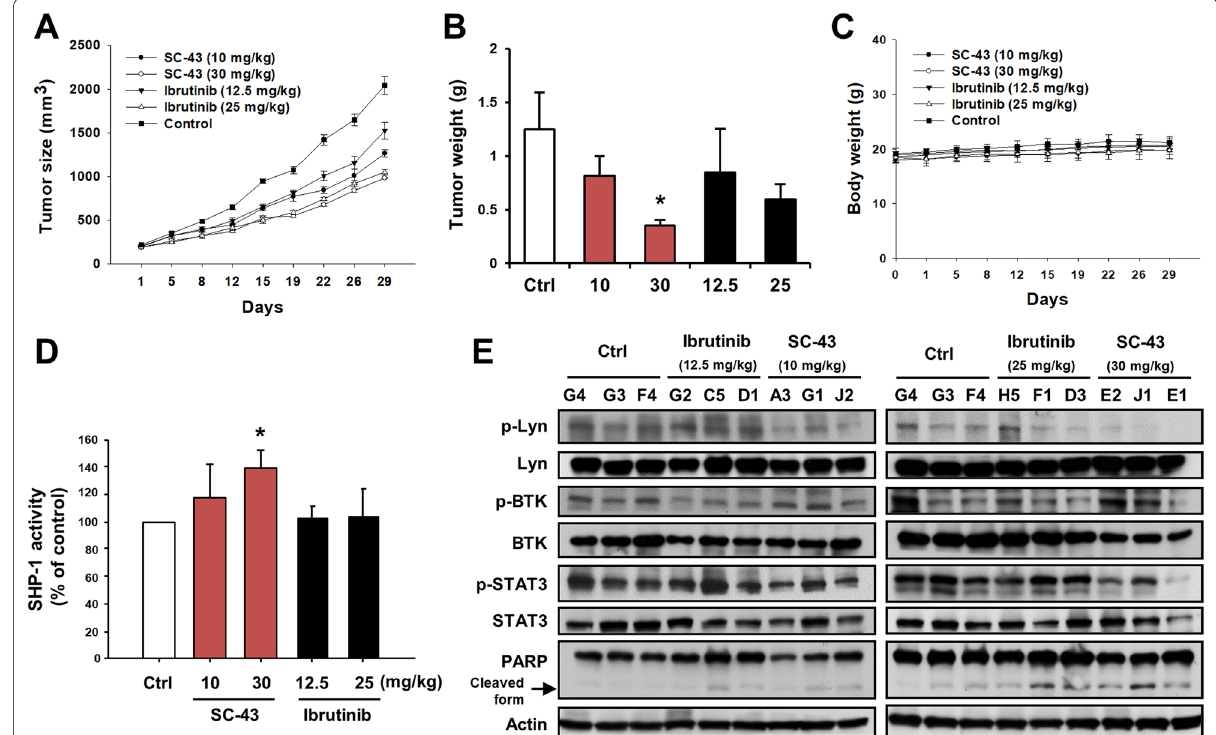
Fig. 1 SHP‑1 agonist suppresses tumor growth through SHP‑1/Lyn pathway in vivo. A – E U2932 tumor‑bearing mice (N vehicle, SC‑43 (10 and 30 mg/kg) or ibrutinib (12.5 and 25 mg/kg) orally three times a week. Tumor growth ( A ), tumor weights (B ), and body weights ( C ) of mice were measured. The SHP‑1 activity and protein expression levels of tumors were analyzed by Tyrosine Phosphatase Assay ( D ) and Western blot analysis ( E ). Student’s t ‑test, * P <